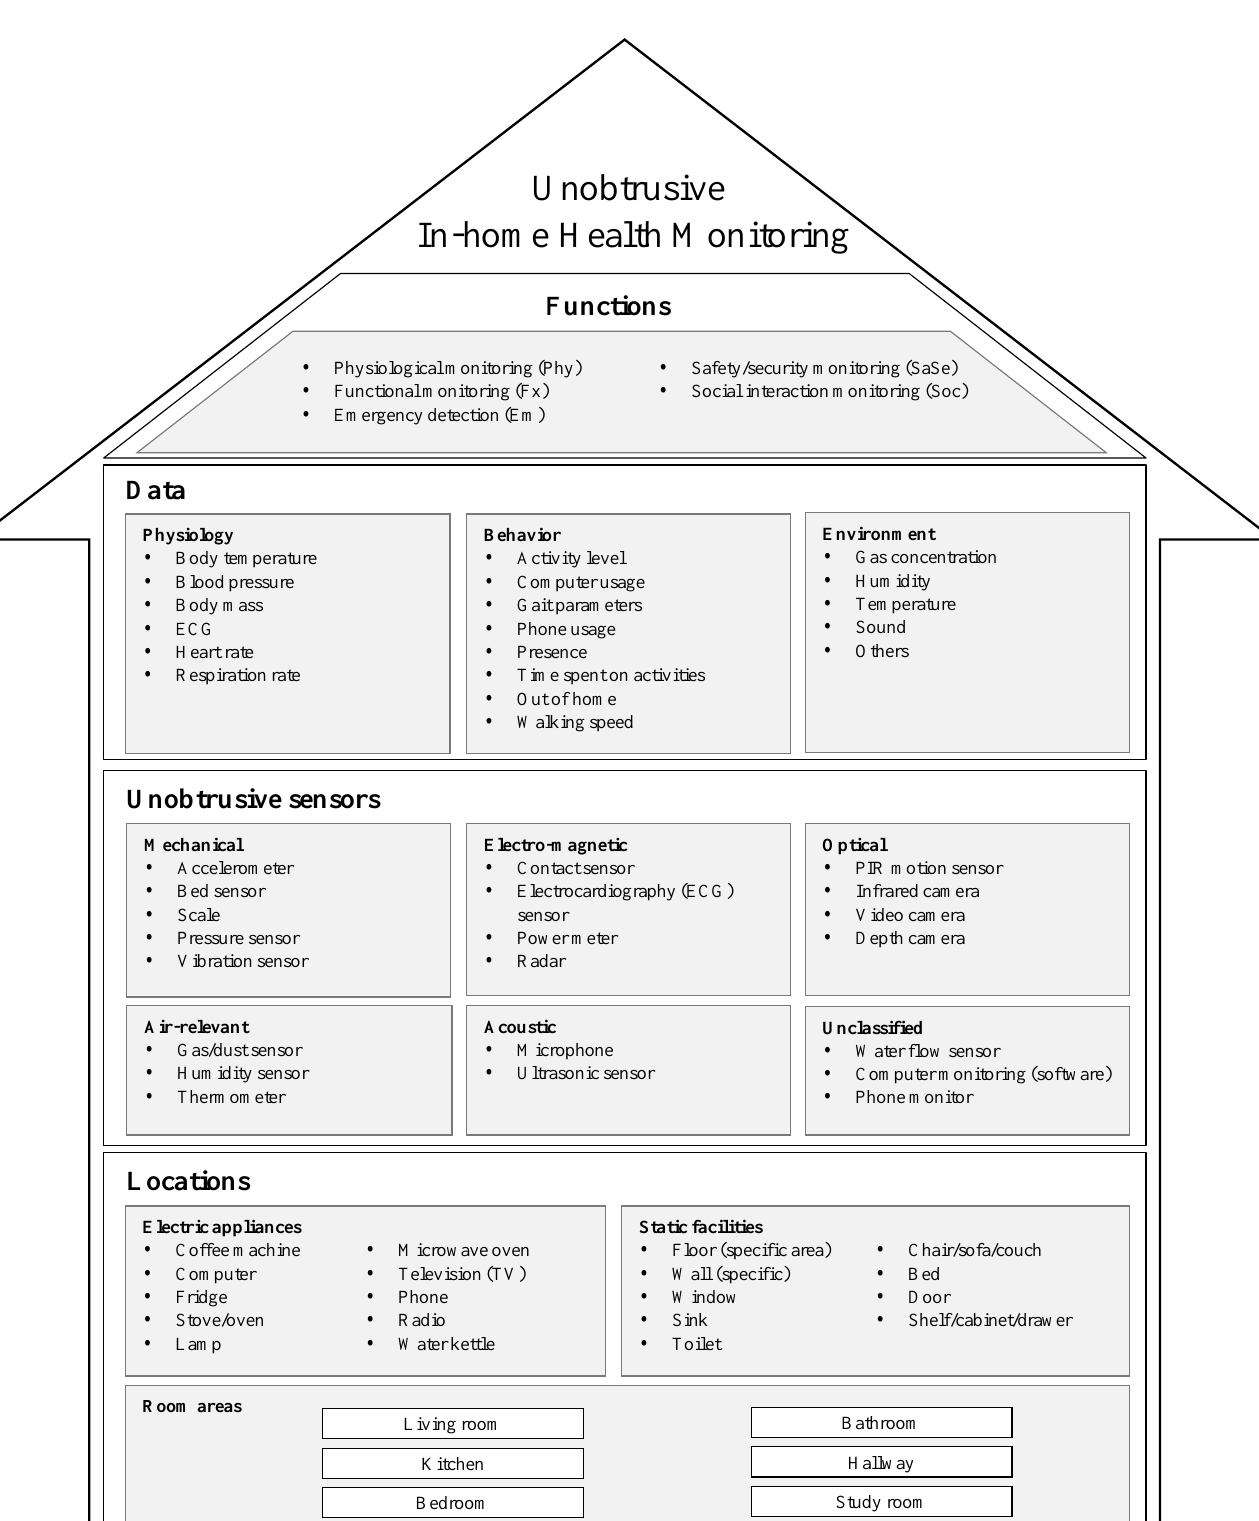
Figure 1. Terminology of unobtrusive in-home health